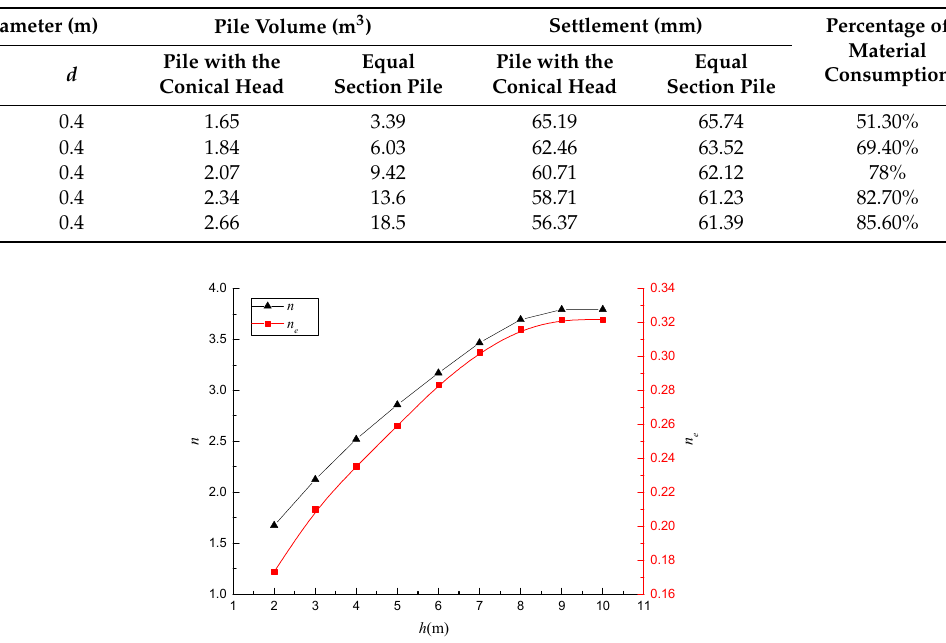
Figure 9. Pile–soil stress ratio and the load sharing ratio vs. the height of the embankment.